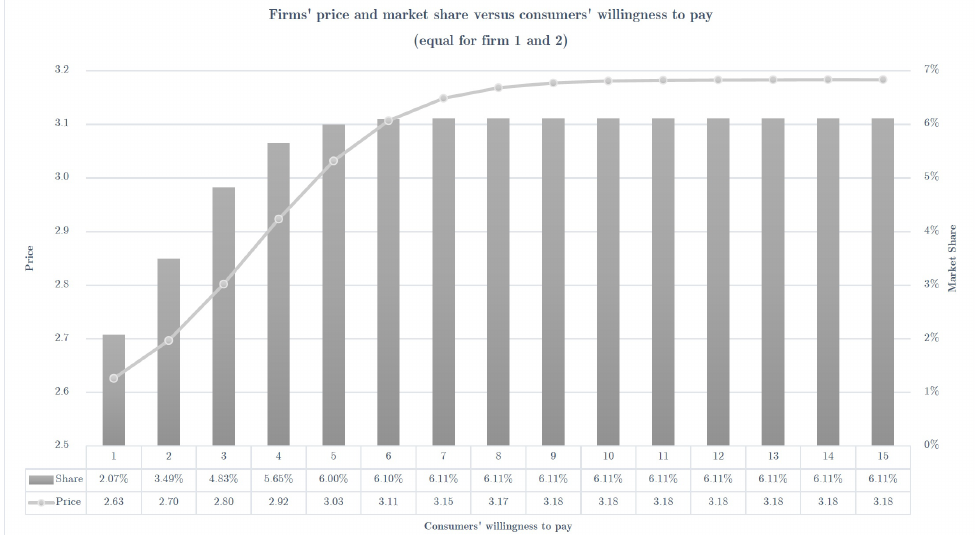
Figure A1. Consumers’ willingness to pay wp effect on prices and market